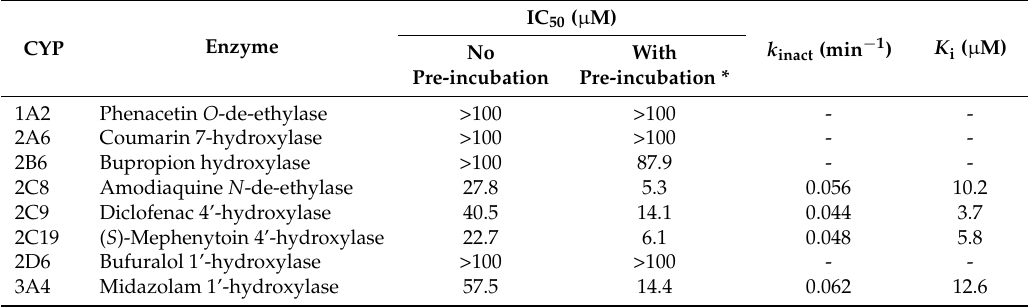
Table 1. Inhibitory effects of aschantin on cytochrome P450 (CYP) metabolic activities in pooled human liver